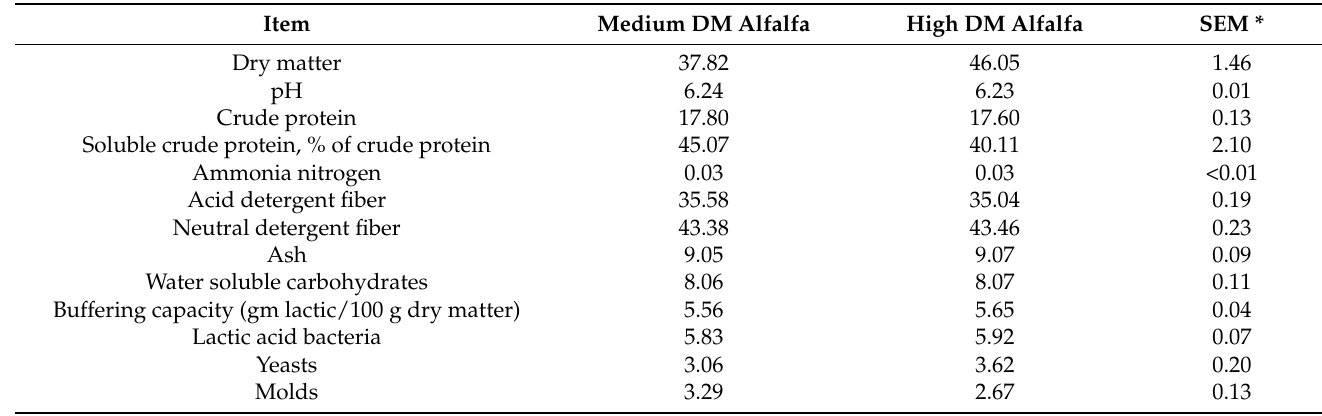
Table 2. Chemical (% DM basis unless stated otherwise) and microbial analysis (log10 cfu/g fresh weight basis) of freshly chopped alfalfa before